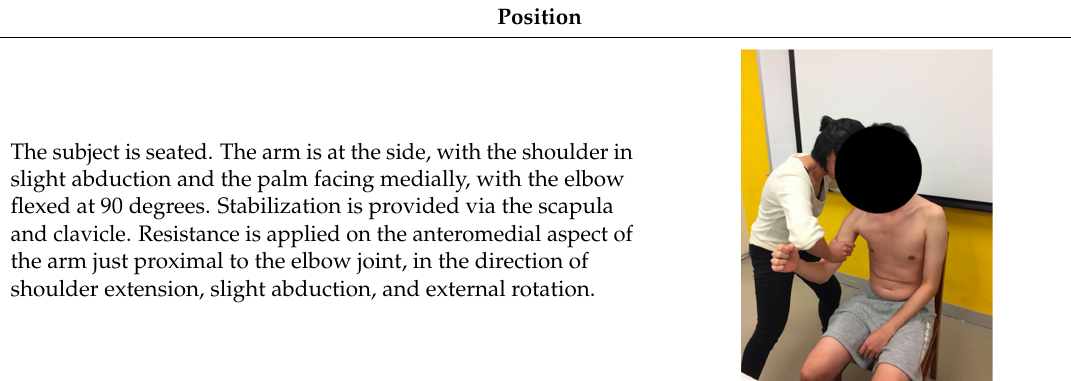
Table 1. Procedures of MVIC tests of the seven shoulder muscles among five subjects from prelimi- nary